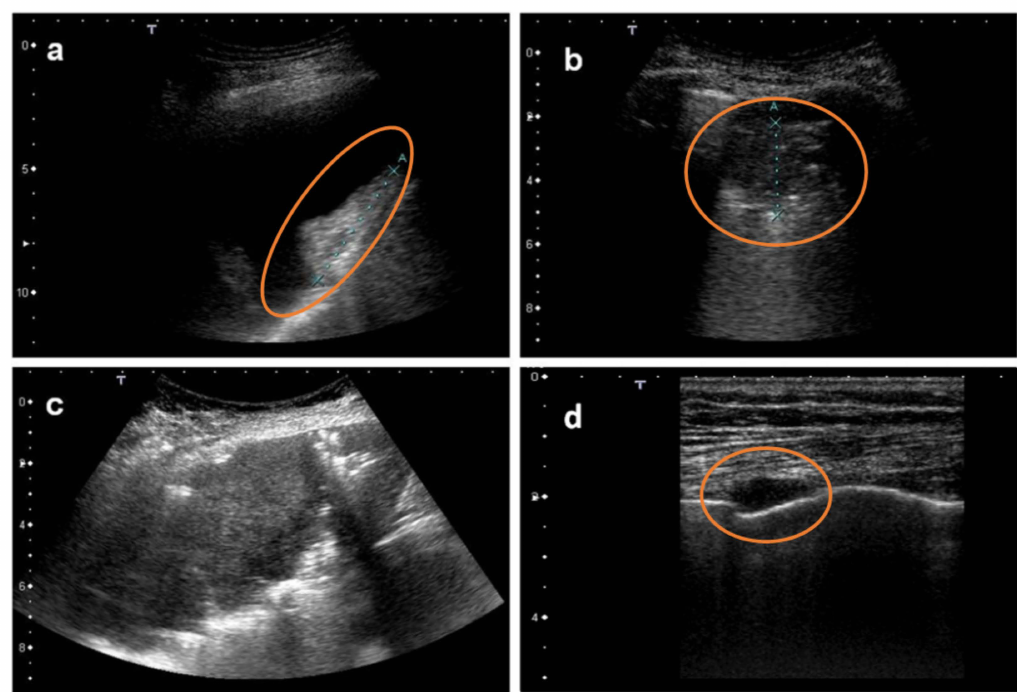
Figure 4. Image ( a ) shows an ultrasound scan of a patient with large pleural effusion and a coarse vegetation on the diaphragmatic surface (metastatic carcinoma in red circle). Image ( b ) shows lung consolidation with poor ventilation (pneumonia in red circle). Image ( c ) shows a large lung consolidation (lung cancer). Image ( d ) shows pleural neoplasia (mesothelioma in red circle).